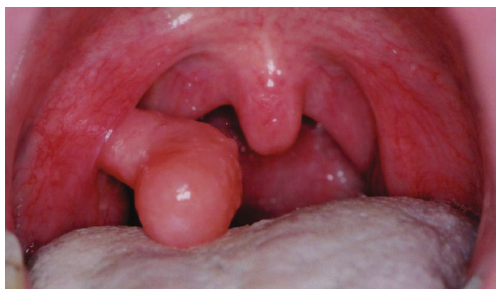
Figure 1: Primary lymphangioma of the tonsil: oral view of the tonsillar lymphangioma of the right tonsil of our